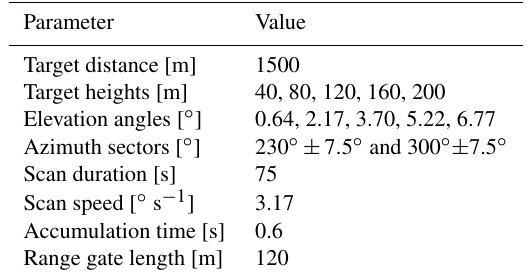
Table 3. Overview of scanning lidar set-up during the measurement